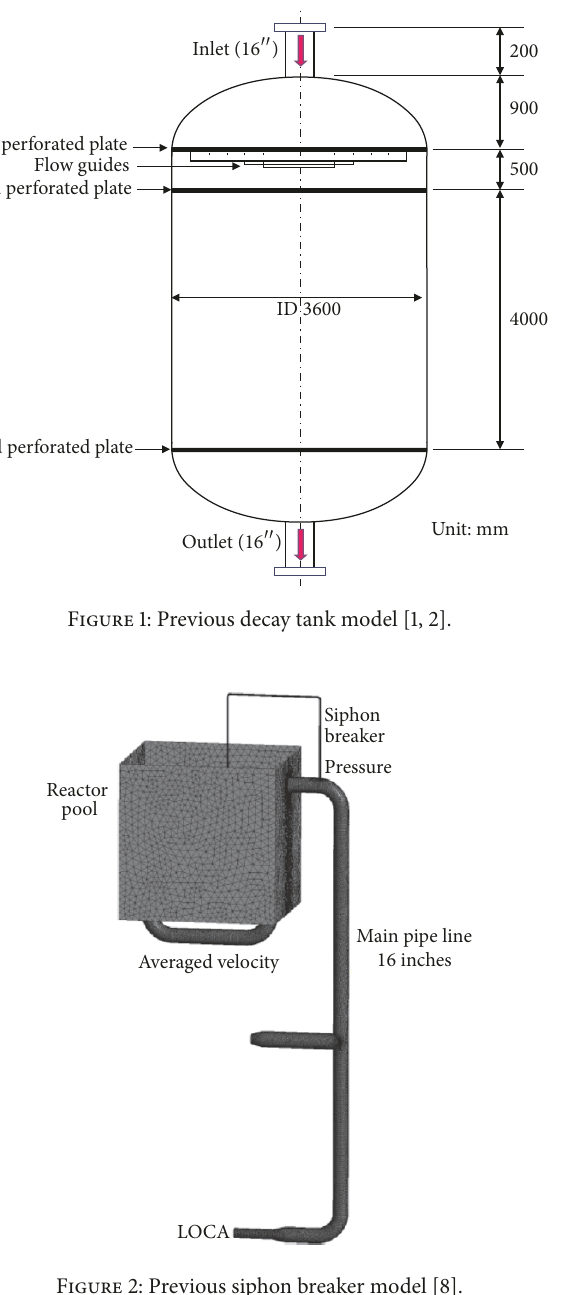
Figure 2: Previous siphon breaker model